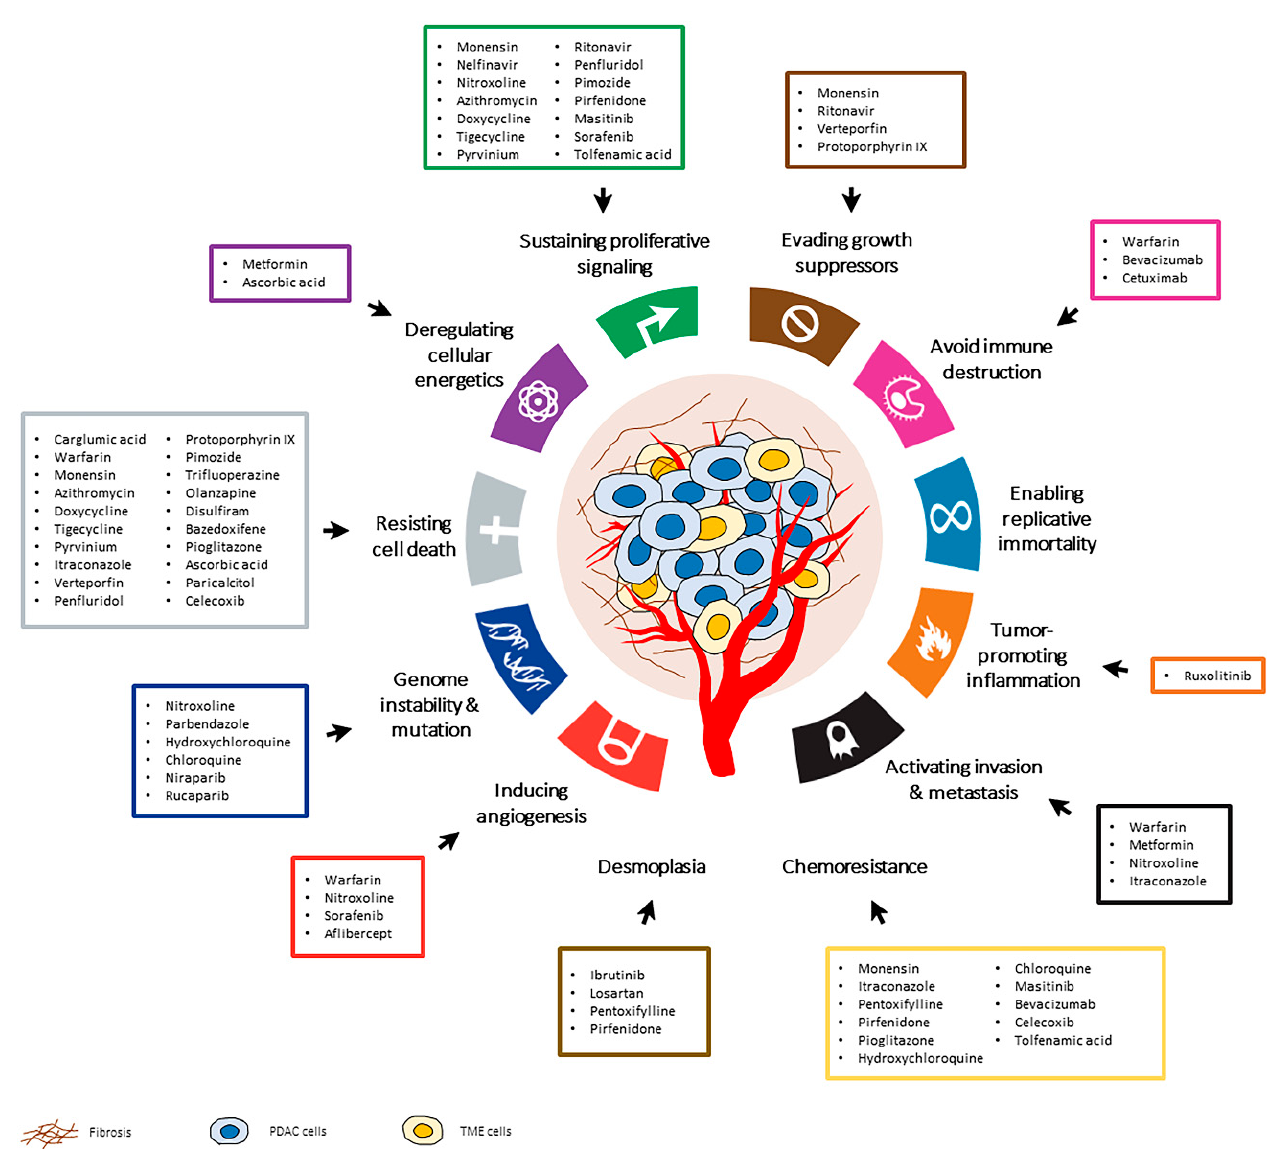
Figure 2. The hallmarks of cancer and other pathological characteristics of pancreatic ductal adenocarcinoma (PDAC) that may be targeted by drug repurposing candidates. These drugs have been investigated in preclinical studies or clinical trials for the treatment of PDAC. Adapted from Hanahan and Douglas et al. 2011.